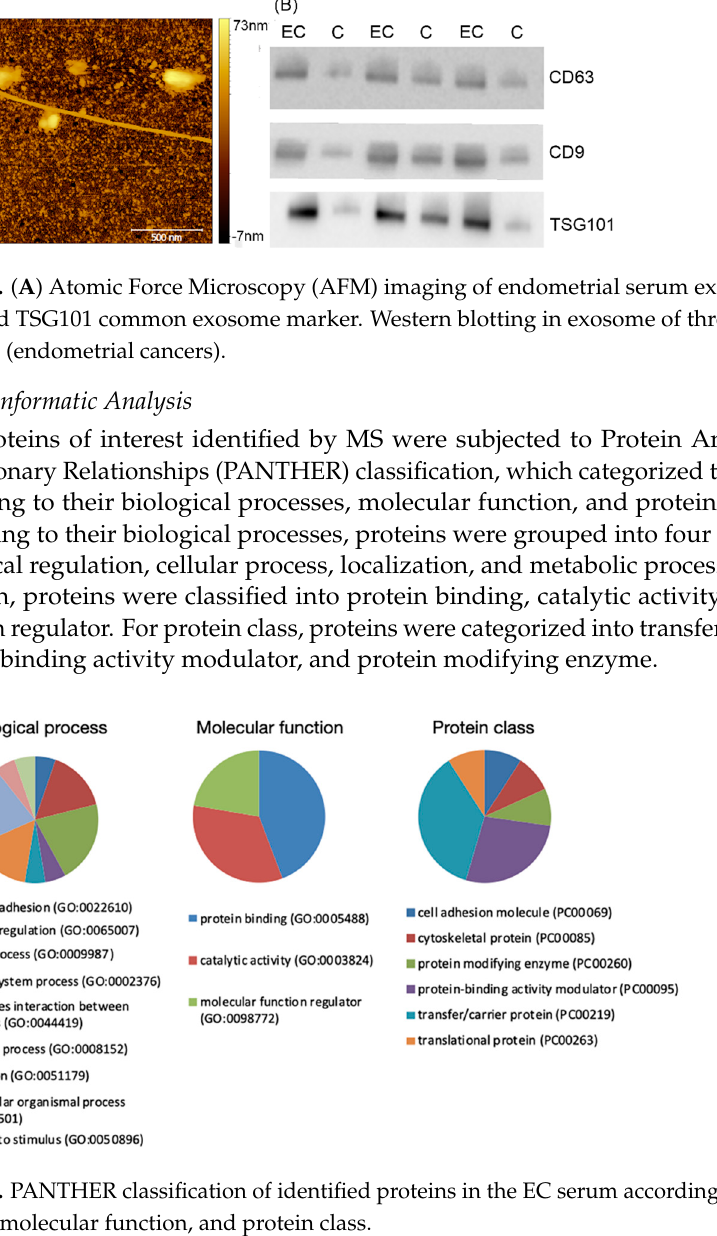
Figure 4. Western blotting of protein ITIH4, CLU, C1R, and SERPIN1 present in tumor tissue.